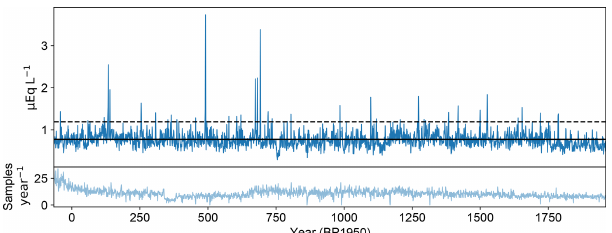
Figure 12. Time series for annually averaged sulfate. Solid black line indicates the 2000-year mean value. Dashed black line indi- cates 2 σ value. The lower panel indicates the number of individual samples in the year used for the average value.